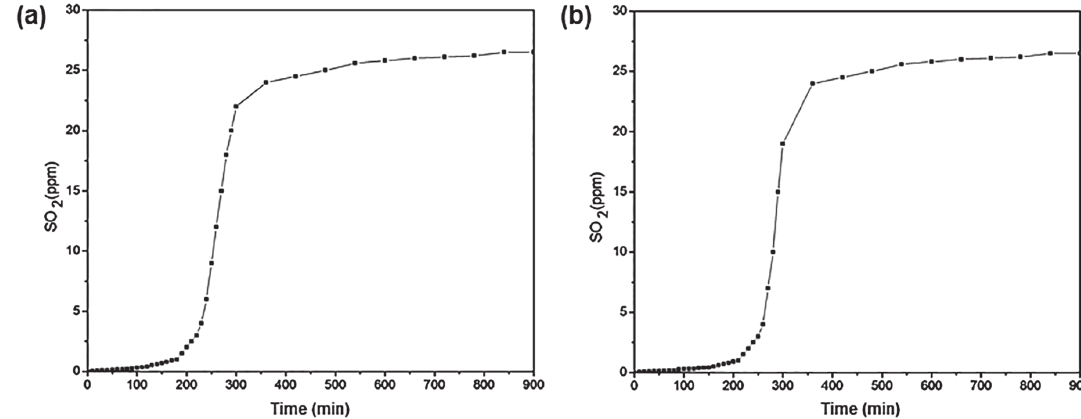
Figure 7 - Evolution of SO